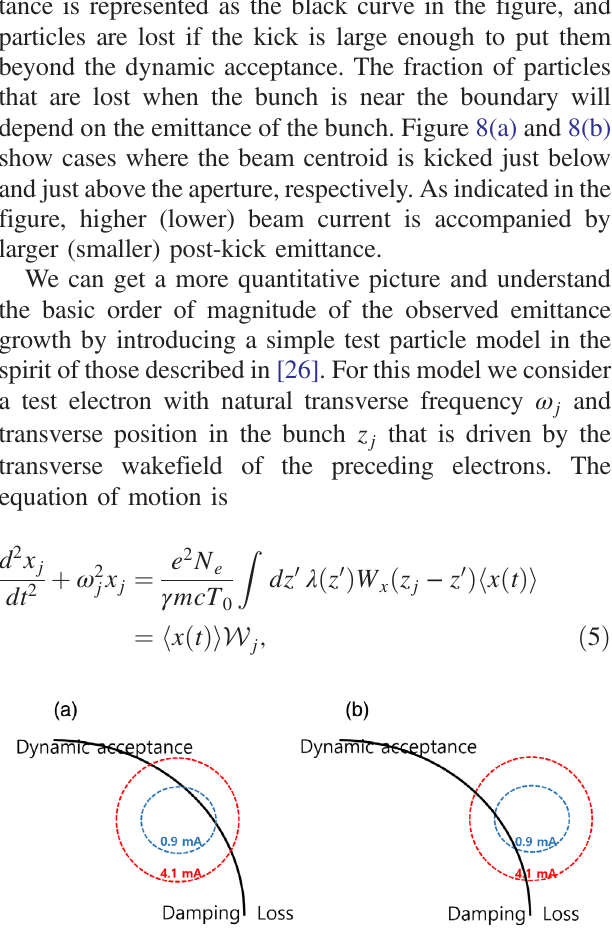
FIG. 8. Schematics for understanding current-dependence of the measured acceptance. The black curve represents the dynamic acceptance (DA), while the colored lines indicate the extent of the beam. For larger bunch current, after being kicked the beam size inflates more significantly due to collective effects. As a result, for a weaker kick (a), a larger fraction of the high-current bunch is lost; more of the low-current bunch is on the damping side of the DA boundary. Similarly, for a stronger kick (b), a larger fraction of the high-current bunch is still within the